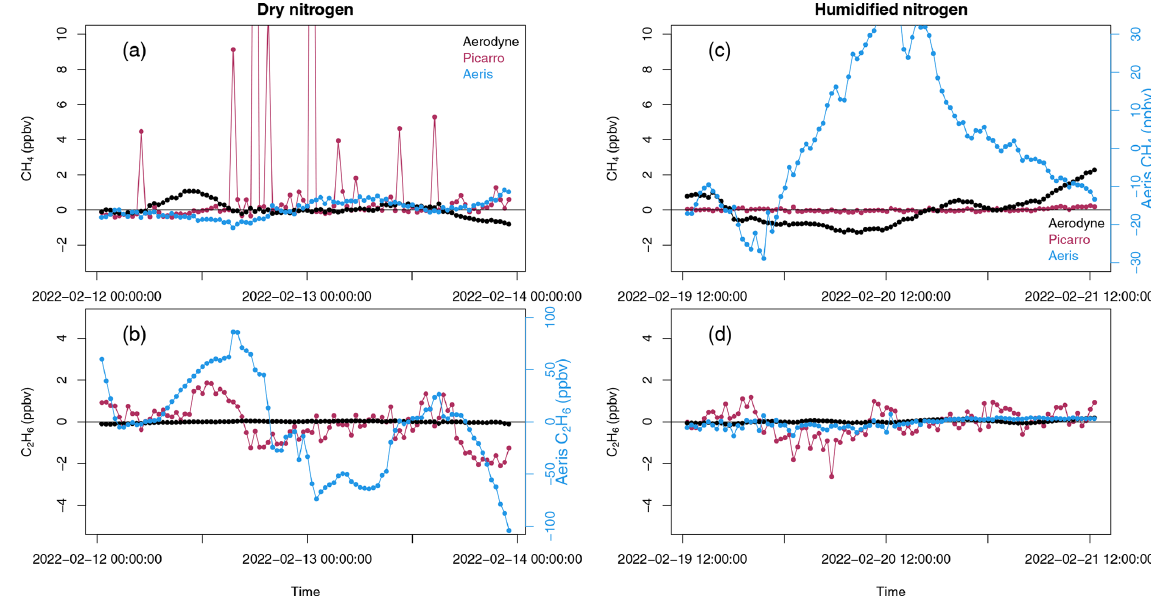
Figure 3. Instrument response when sampling (a–b) dry and (c–d) humidified methane (a, c) and ethane (b, d) in nitrogen. Picarro G2210-i (red) and Aeris MIRA (blue). Note the separate right y axis for the Aeris (b) ethane and (c) methane. Also note that the Aerodyne SuperDUAL (black) did not sample humidified nitrogen in (c) – (d)